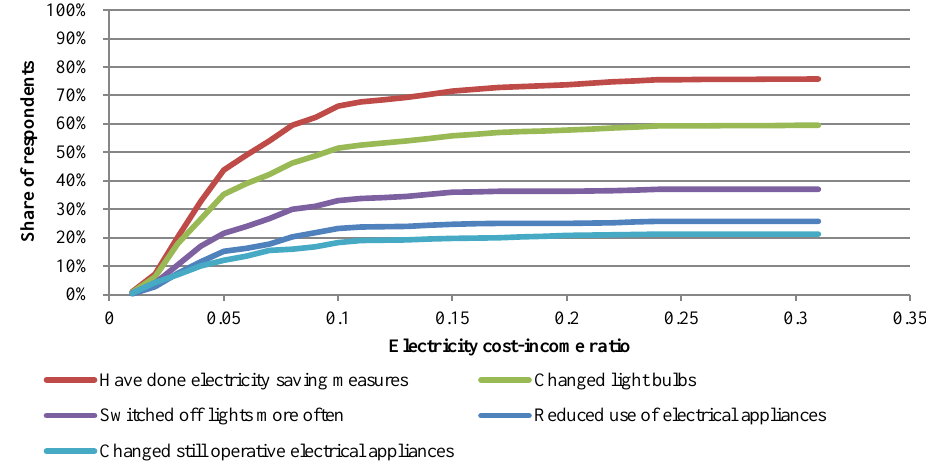
Fig. 6. Relation between the share of respondents and electricity saving measures accomplished during the last three years, and the electricity cost-income ratio within the low-income households.